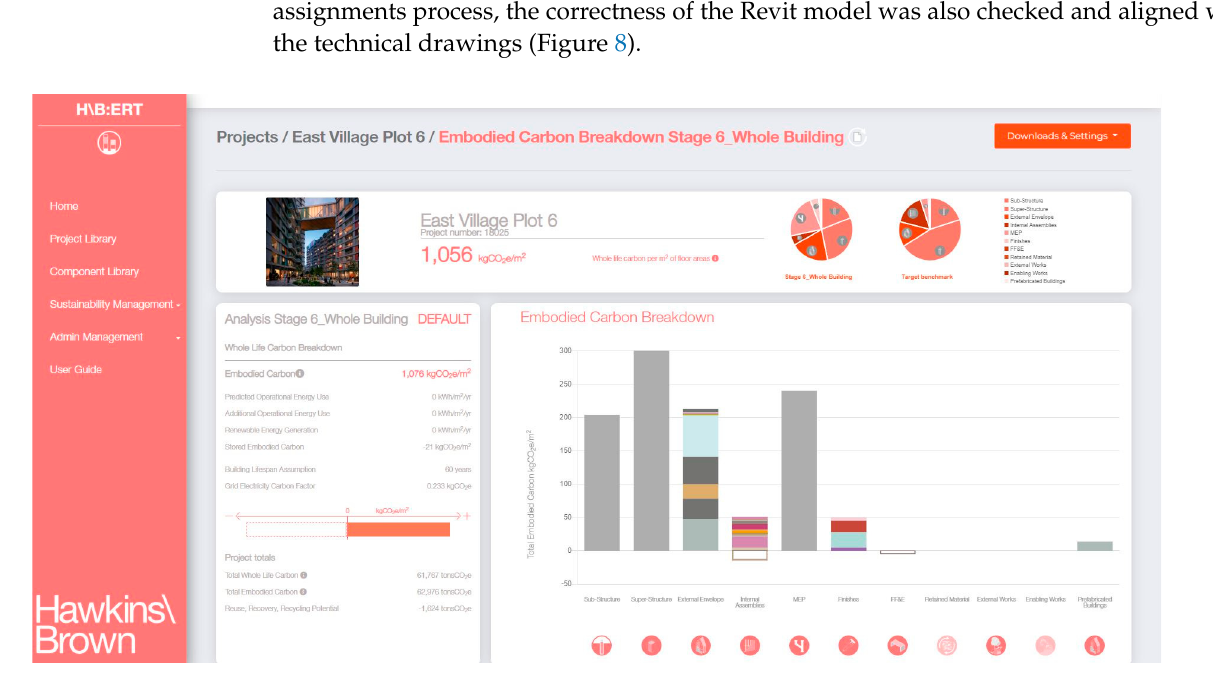
Figure 8. HBERT web-tool interface.